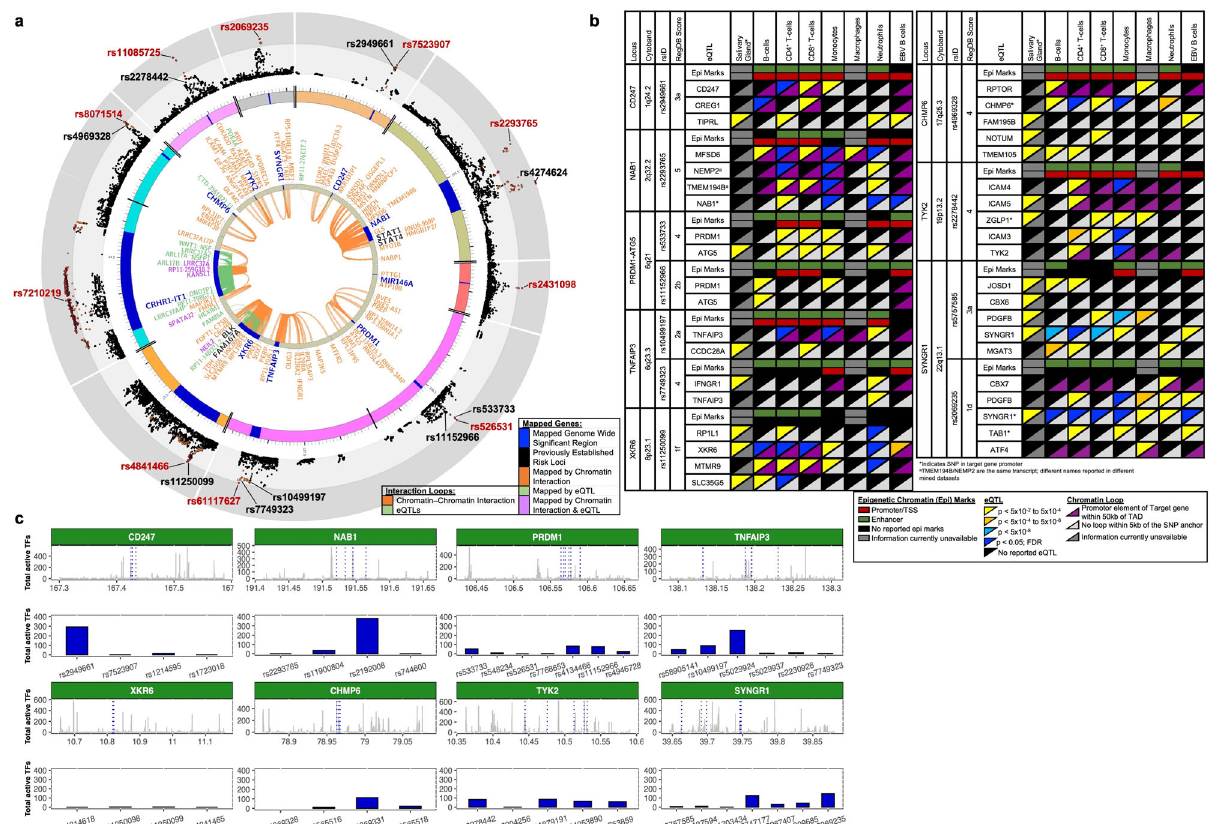
Fig. 5 Chromatin Interactions and eQTLs of the ten novel Sjögren-associated genetic risk loci. a Circos plot shows the zoom regional Manhattan plots for each genetic risk locus (outer most layer); SNPs with P -value <0.05 (black); r 2 > 0.08 (red); r 2 > 0.06 (orange). Index SNP rsIDs are indicated in red. Black rsIDs are prioritized SNPs from the 95% credible set that are also eQTLs that exhibit chromatin-chromatin interactions and are shown in ( b ). Outer circle displays the chromosome coordinate with the genomic risk loci highlighted in blue. Genes that are eQTLs (green) or exhibit chromatin interaction by Hi-C in Epstein – Barr virus (EBV)-transformed B lymphocytes (orange) are reported on the inner circles as text or interaction links. Each index gene is colored blue. Genes that are eQTLs and engage in chromatin interactions are reported in purple. b Cell type-speci fi c functional annotations (horizontal rectangles), select eQTLs (top triangles), and chromatin-chromatin interactions (bottom triangle) are shown for the indicated prioritized SNPs from each 95% credible set. MIR146A was omitted because mined eQTL databases did not test MIR146A . Complex linkage disequilibrium of the CRHR1 association impaired re fi nement and fi ne-mapping of the region. c IMPACT annotation of the most likely functional Sjögren-SNPs to quantify SNP position in 700 cell- type-speci fi c active transcription factor binding sites. Top panel depicts SNP position (blue lines) relative to genomic coordinates (Mb) of each indicated locus. Bottom panel shows the total number of active transcription factor binding sites detected at each indicated ( NAB1 ) gene (Fig. 2b; Supplementary Data 17, 18) 49 . SNP rs2293765